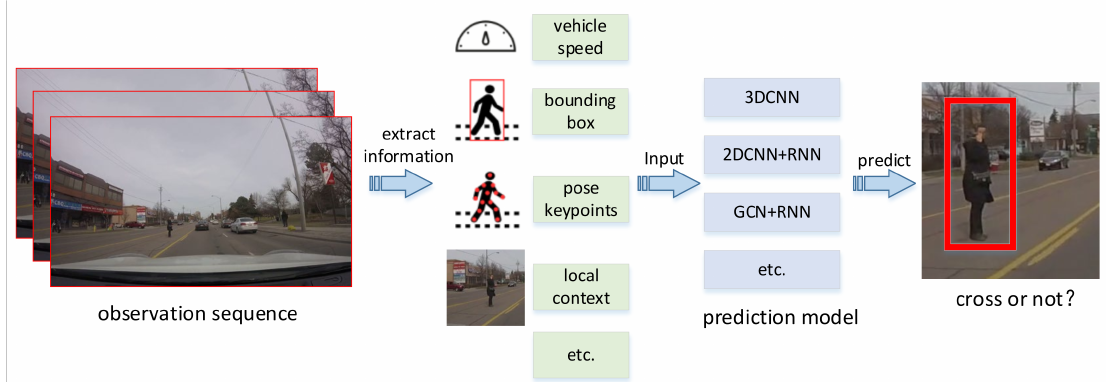
Figure 1. Overview of current mainstream pedestrian crossing behavior prediction methods. Firstly, the required information is extracted from the observation sequence, including pedestrian posture, pedestrian trajectory, local environment, vehicle speed and so on. Then input the information into the spatiotemporal feature processing network for behavior